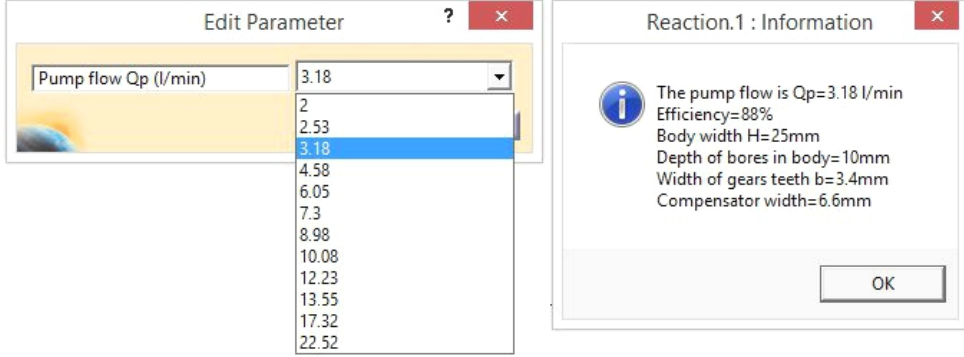
( b ) Figure 4. Parametric model of the pump for the flow rate of 2 L/min ( a ) and of 22.52 L/min ( b ). Certain standard components of the assembly (i.e., cover, screws and gaskets) were not represented in the figure to simplify it and only to highlight how the parameterized components are changed.